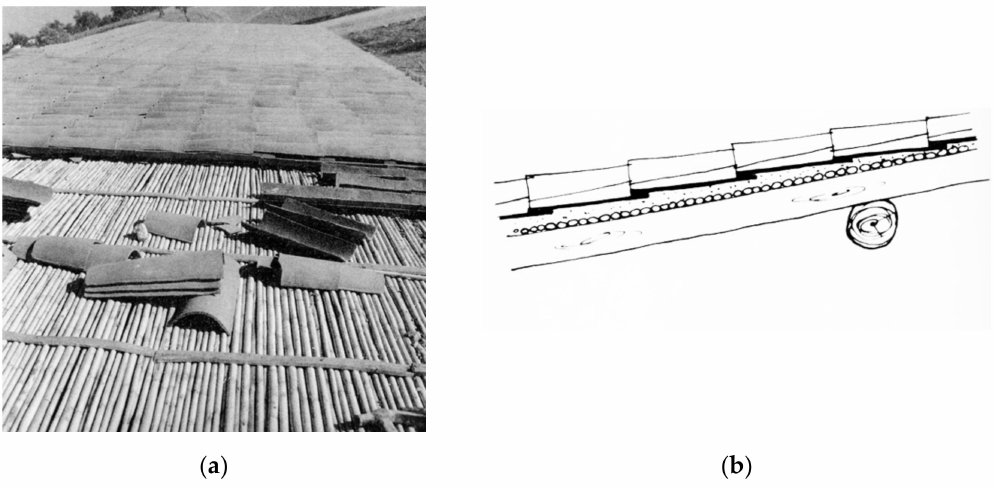
Figure 1. Use of reed for roof construction: ( a ) common gable building [8] and ( b ) section of a roof